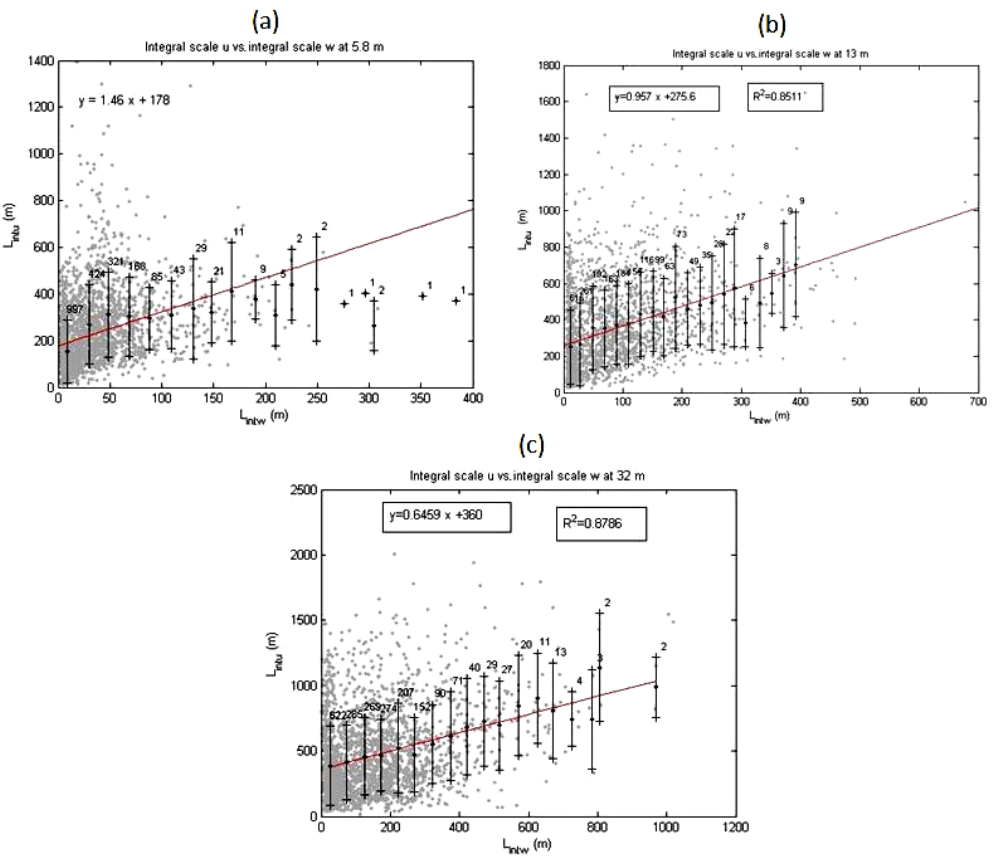
Figure 10. Comparison of integral scales of the u (cid:48) component and w (cid:48) component (a) at 5.8m, (b) at 13m and (c) at 32m, showing that the average values of theses scales fit to the linear regression indicated on the top left each graph. The data set appears as a cluster around the straight